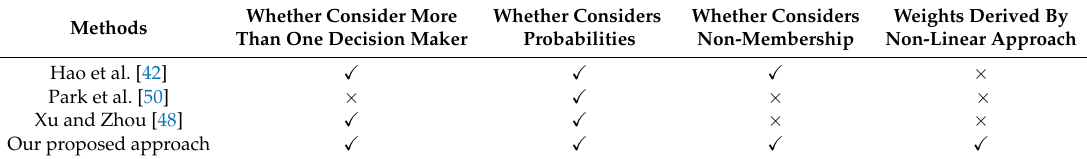
Table 7. Characteristic comparison of the proposed approach with different